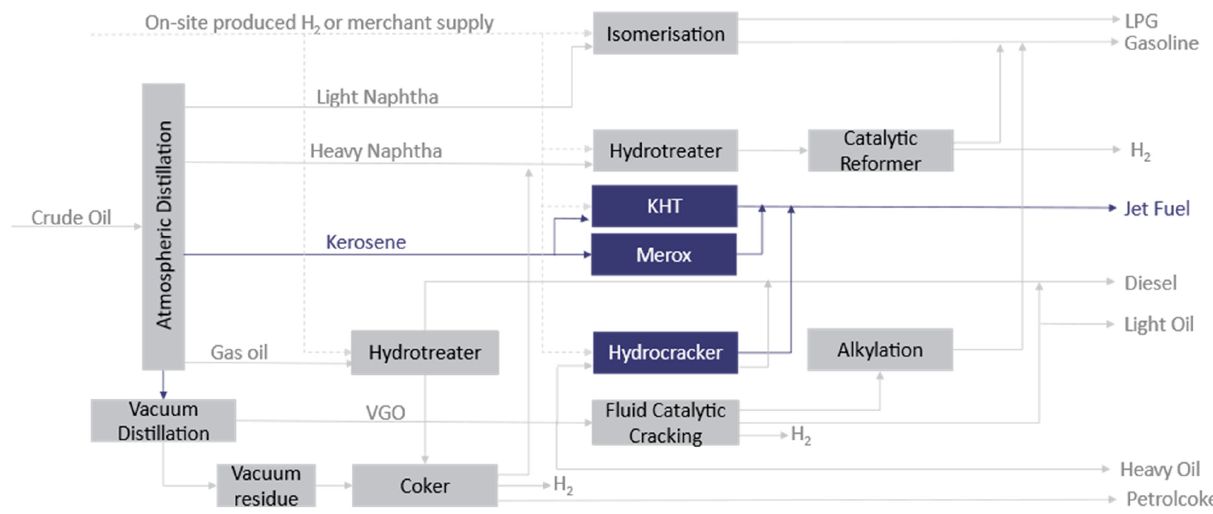
Figure 2. Flow diagram for a typical refinery.